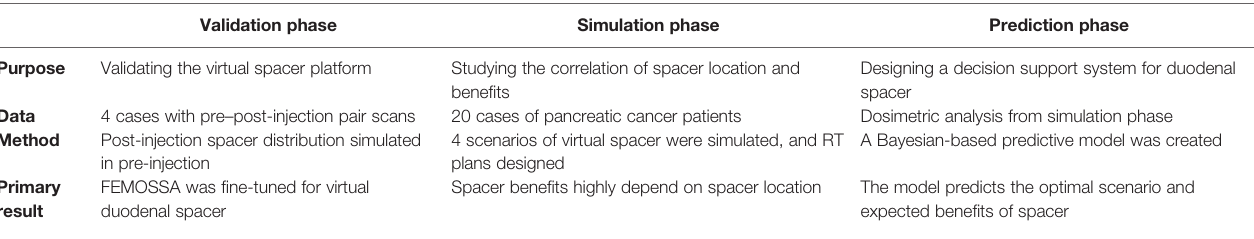
TABLE 1 | An overview of the three phases of the